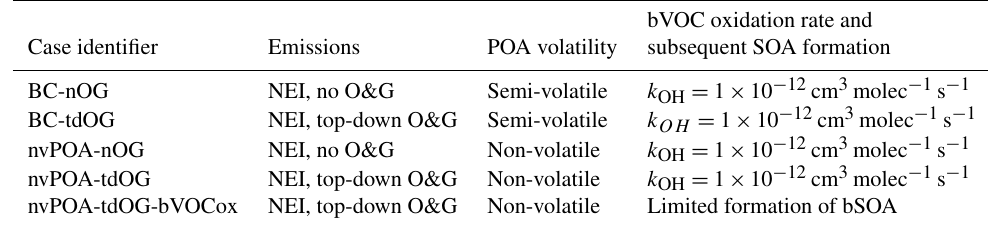
Table 2. Details on input parameters and assumptions used in the different WRF-Chem simulation